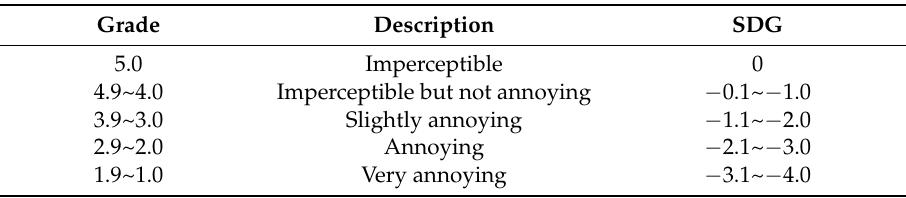
Table 1. Subjective difference